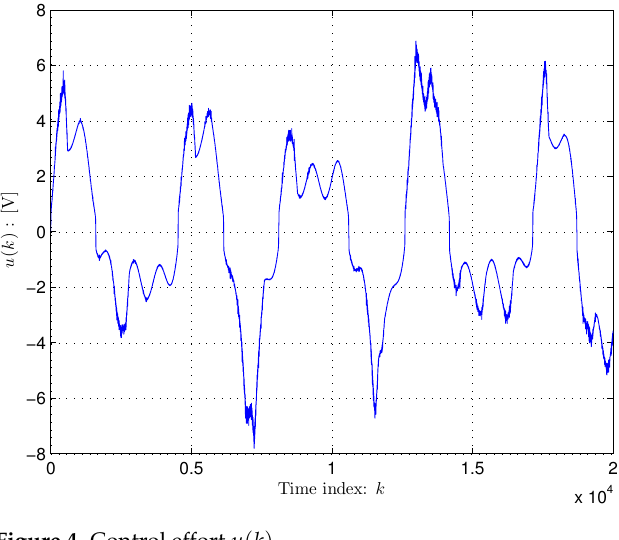
Figure 4. Control effort u ( k ) .